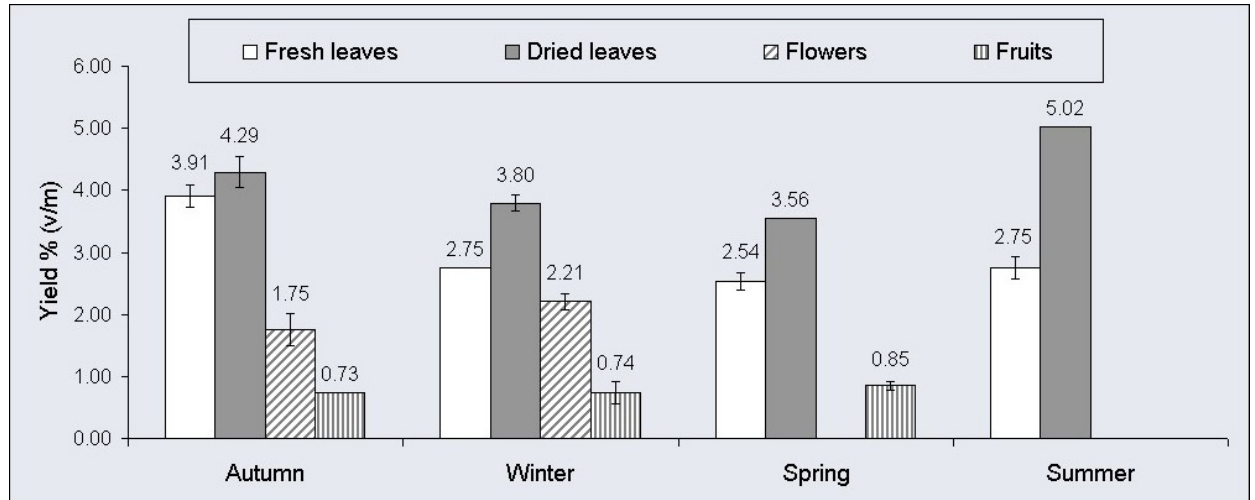
Figure 1. Yield of essential oils from aerial parts of E. cinerea